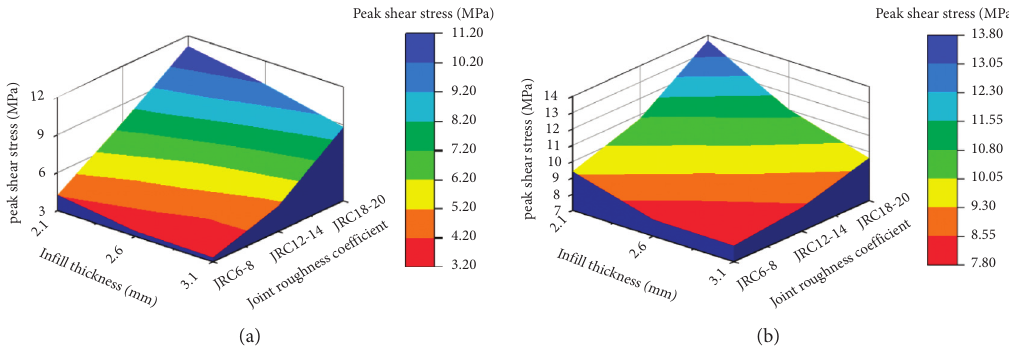
Figure 20: Relationship between peak shear stress and coupling of joint roughness and infill thickness for infilled rock joints: (a) unbolted; (b) bolted. Table 3: Relationship between peak shear stress and coupling of joint roughness and infill thickness for unbolted infilled rock joints. Infill thickness